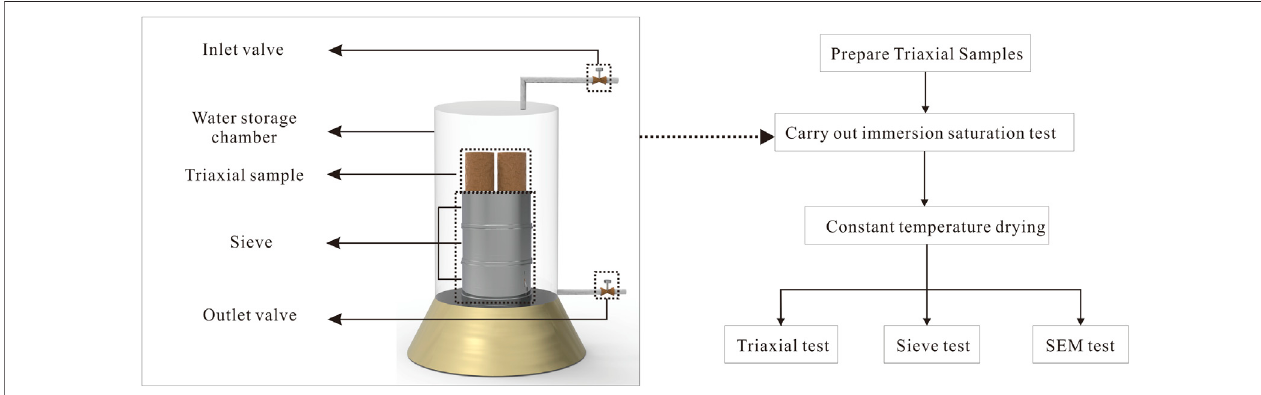
FIGURE 6 | Schematic diagram of the test